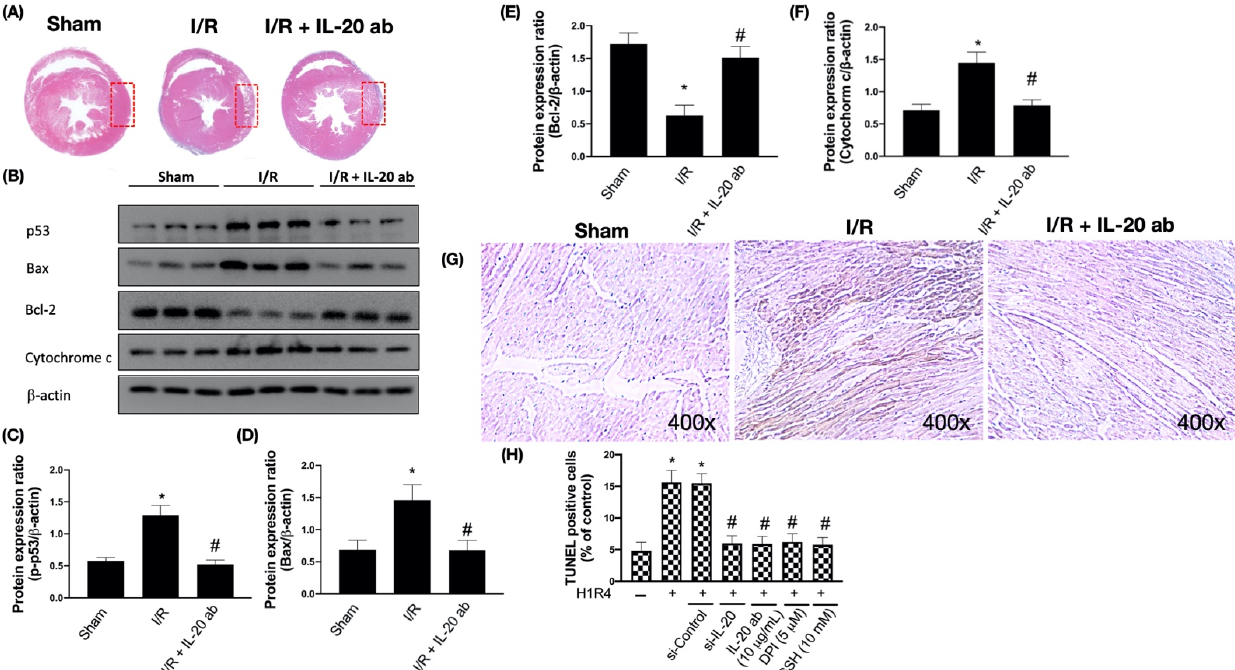
Figure 2. Interleukin (IL)-20 antibody reduces ischemia/reperfusion (I/R)-induced apoptosis by modulation of the mitochondria-dependent apoptosis pathways. Sprague Dawley rats receiving sham operation or I/R treatment were studied. In the IL-20 antibody treatment group, animals were injected with 5 mg/kg IL-20 antibody at the phase of reperfusion. ( A ) Histological assessment of infarct area after I/R was shown. Tissue sections were obtained from formalin-fixed heart slices that were treated with hematoxylin and eosin staining. The left ventricular tissues were collected for Western blotting assay. Representatives of Western blot ( B ), and the densitometric analysis of p-53 ( C ), Bax ( D ), Bcl-2 ( E ), and cytochrome c ( F ) were shown. ( G ) Apoptosis in tissue was analyzed by terminal deoxynucleotidyl transferase dUTP nick end labeling (TUNEL) assay. ( H ) Apoptosis in H9C2 cells after hypoxia/reoxygenation (H/R) was presented by TUNEL assay using flow cytometry. H9C2 cells that had been first exposed to hypoxia chamber with oxygen-glucose deprivation (OGD) for 1 h were moved into the normoxia chamber with high glucose medium for further 4 h, a condition abbreviated as H1R4. In some cases, cells were transfected with si-Control or si-IL-20 for 48 h before OGD. In the IL-20 antibody treatment group, 10 µ g/mL IL-20 antibody was added to medium during H/R. Glutathione (GSH), an antioxidant, was used for mitigating oxidative stress. Diphenyleneiodonium chloride (DPI), an inhibitor of nicotinamide adenine dinucleotide phosphate (NADPH) oxidase, was used to inhibit H/R-induced NADPH oxidase activation. Data were presented as the mean ± standard deviation of three different experiments. (* indicating p < 0.05 compared to the sham group or normoxia control cells; # indicating p < 0.05 compared to the I/R group or H/R cells). Sham: thoracotomy without ischemia/reperfusion; I/R: thoracotomy with ischemia/reperfusion; I/R + IL-20 ab: thora-cotomy with ischemia/reperfusion plus IL-20 antibody injection. “ − ” indicated cells were exposed to normoxia cham-ber; “+” indicated cells were exposed to hypoxia chamber for 1 h followed by 4 h